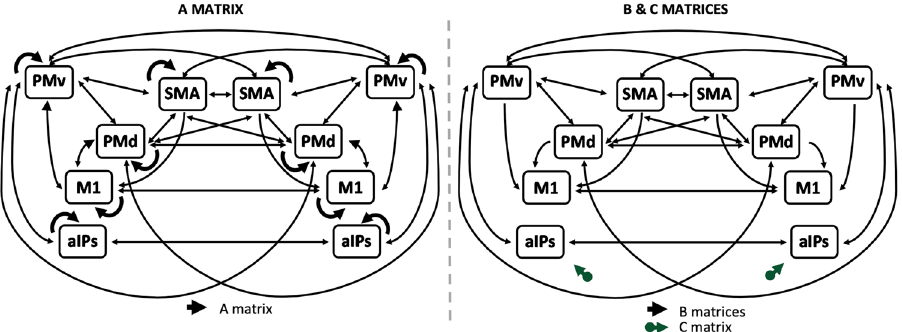
Figure 1. Model for the effective connectivity analysis. Black arrows represent connectivity between brain regions as modelled in the A (baseline; left panel) and B (modulatory; right panel) matrices. Modelled driven inputs (C matrix) are shown as green arrows in the right